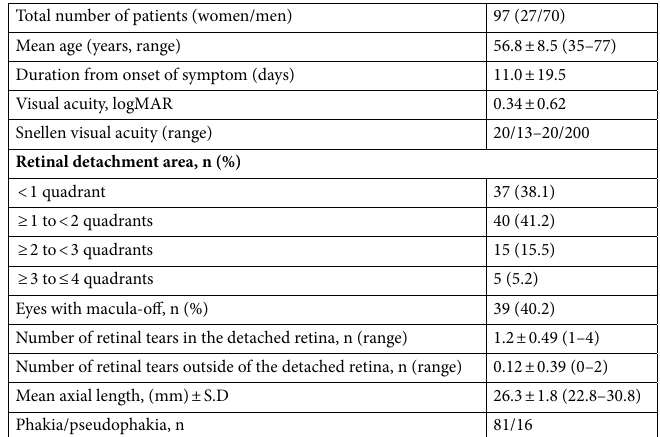
Table 1. Characteristics of patients with rhegmatogenous retinal detachment. The data are shown as the mean ± standard deviation unless otherwise indicated.